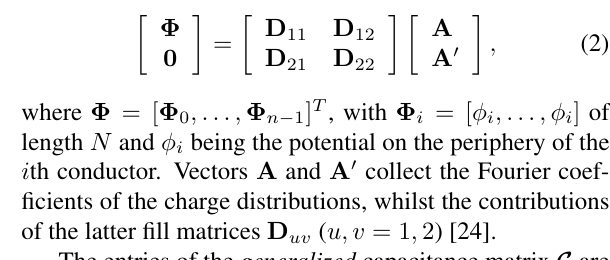
Figure 1: System of dielectric-coated wires. The charge distributions ρ k and ρ ′ on the k th conductor and dielectric k peripheries, respectively, are indicated, together with the potential ϕ i and the normal components of the displacement field ⃗ D they produce on conductor i ( k, i = 0 , . . . , n − 1